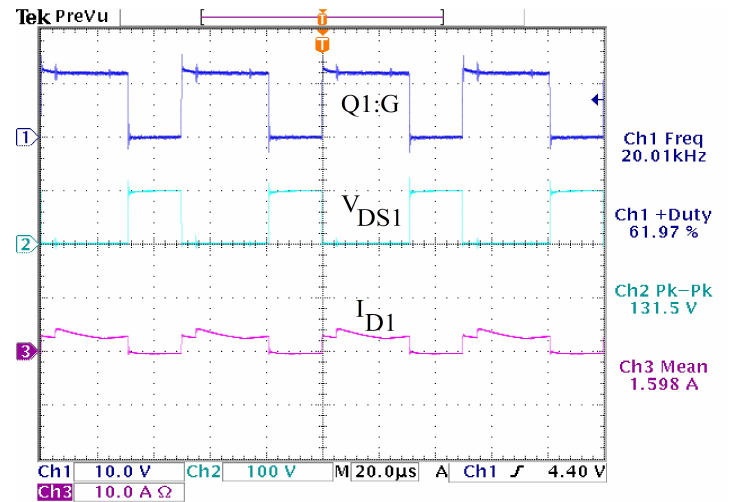
Figure 14. Switch stresses of